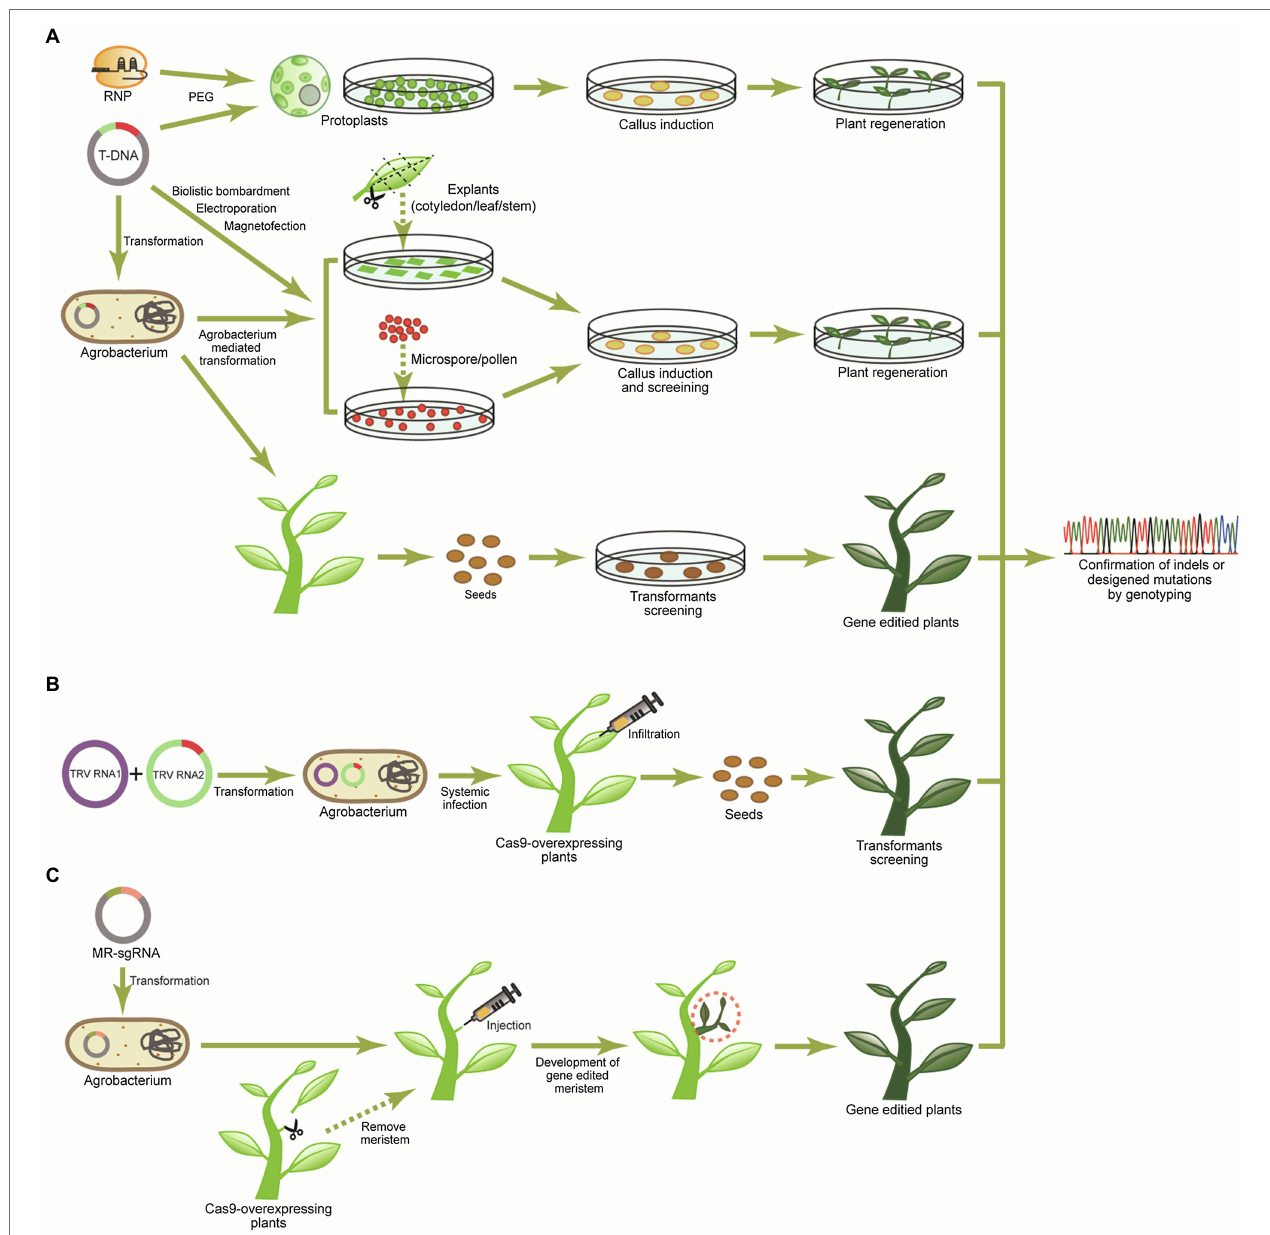
FIGURE 3 | Strategies for delivery of the CRISPR-Cas system into plants. (A) The preassembled CRISPR-Cas9 ribonucleoproteins (RNPs) can be delivered into protoplasts through the polyethylene glycol (PEG)-mediation, and T-DNA encoding CRISPR-Cas reagents [Cas protein and sgRNA(s)] can be delivered into the rigid plan cells (explants, microspores/pollens, and intact plants) using Agrobacterium -mediated transformation, biolistic bombardment, and magnetofection. Subsequently, regeneration procedures of protoplasts and tissues carrying CRISPR-Cas reagents are needed to produce genome edited lines. (B) In the virus- induced gene-editing system, sgRNA fused with RNA mobile element is integrated into tobacco rattle virus (TRV) RNA2. After transformation of TRV RNA1 and TRV RNA2 to Agrobacterium , infiltration is conducted to Cas9-overexpressing plants resulting in systemic spreading of the sgRNA by the mobile elements and induction of mutagenesis. (C) For de novo meristem induction system, the meristems of Cas9-overexpressing plants are removed for infiltration, and then, Agrobacterium carrying morphogenic regulators (MRs) and sgRNA are injected into pruning sites. MRs induce the de novo gene-edited meristem, and the gene-edited plants can finally be obtained from newly developed